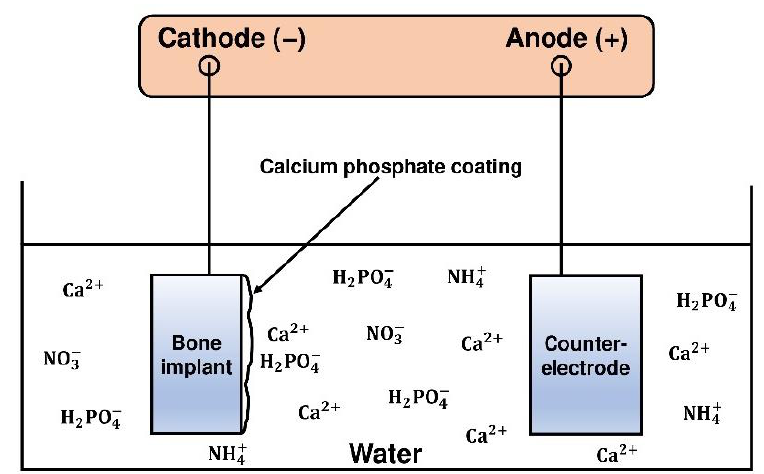
Figure 2. Sketch of the experimental setup used for electrodeposition.